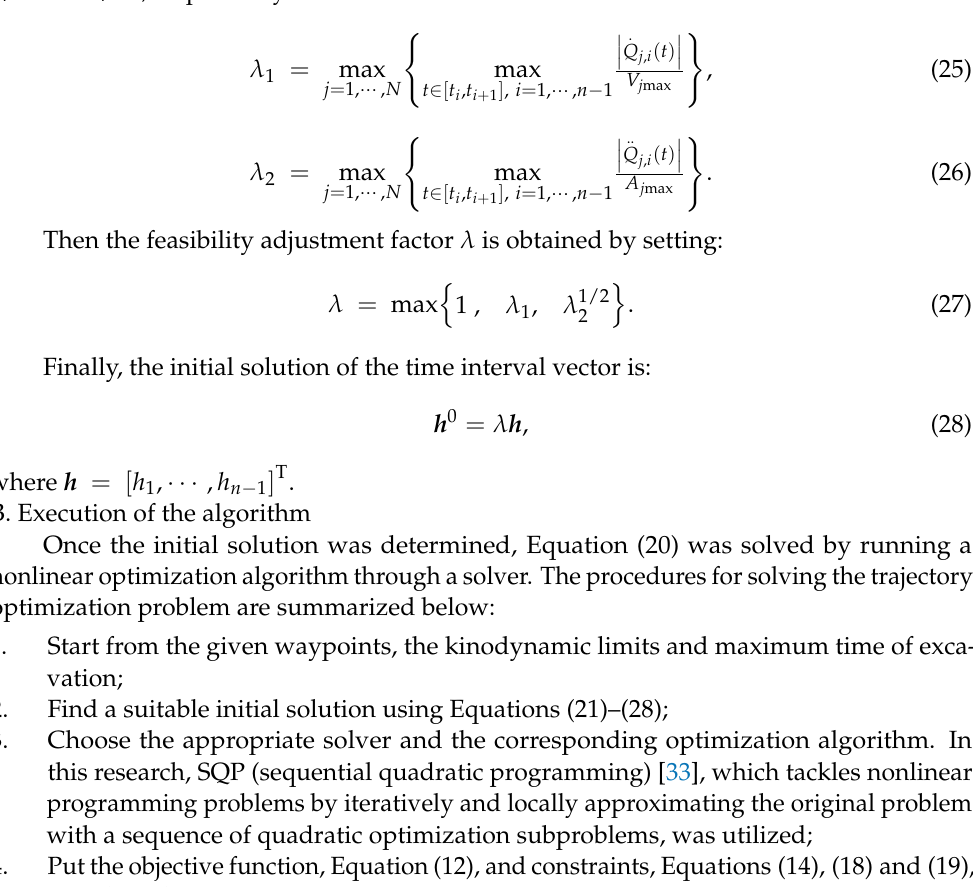
Table 1. Computing resources included a laptop computer, which had a dual-core Intel i5-3210 processor running at 2.50 GHz with 12 GB RAM and a BODAS controller. We